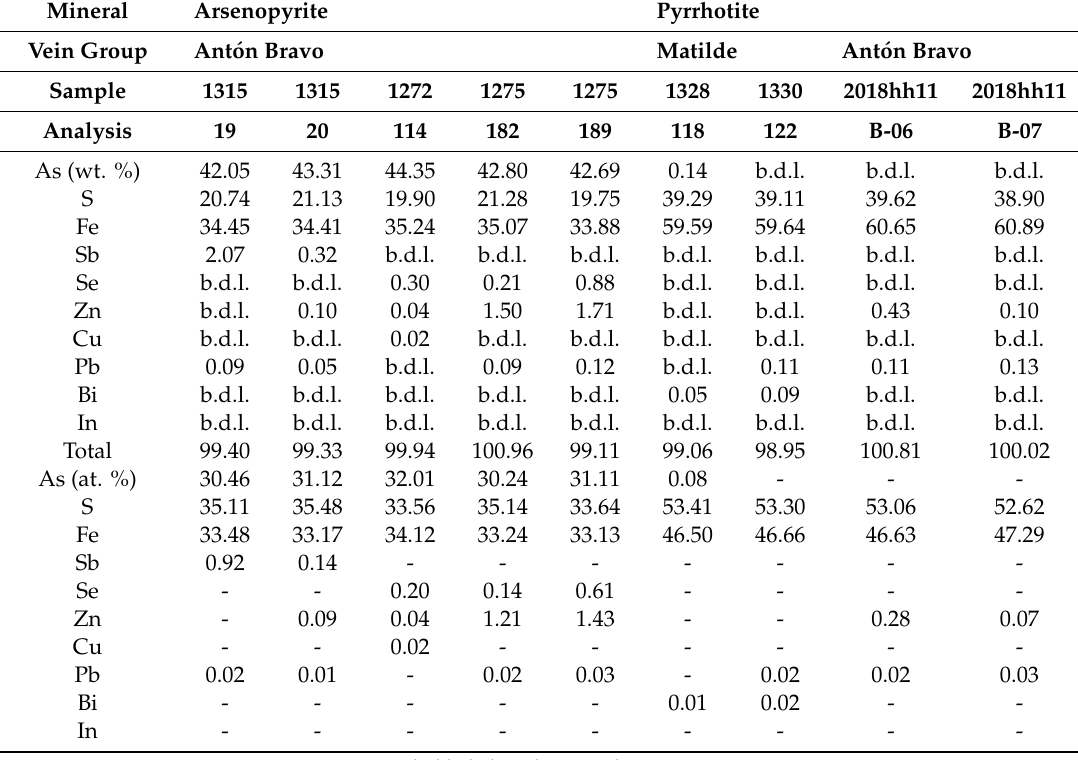
Table 1. Representative analyses of arsenopyrite and pyrrhotite from the Huari Huari district, including chemical composition in wt. % and at. % (electron probe microanalyses). Lower detection limits are given in Table